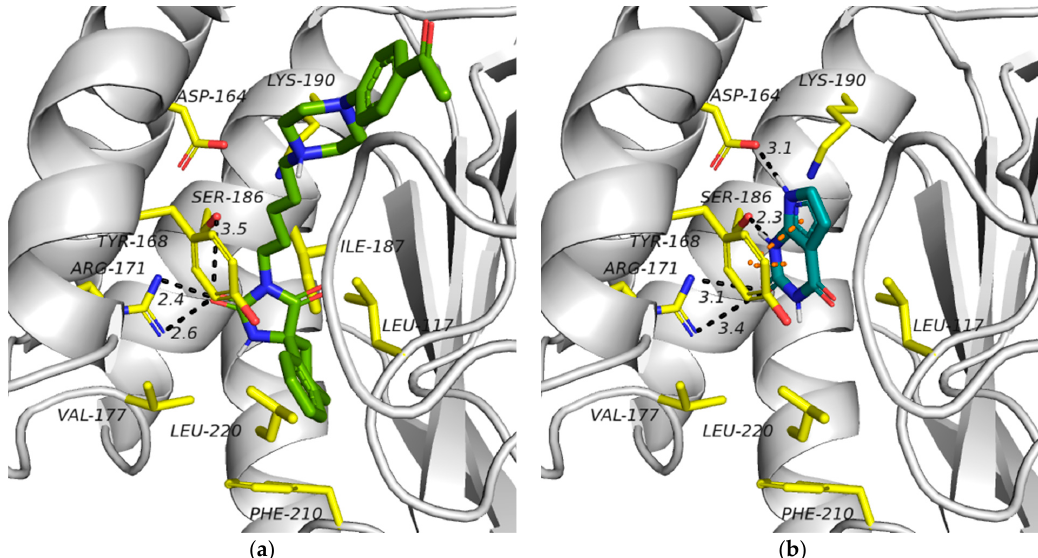
Figure 4. Binding mode of the R -isomer of compound 4 ( a ) and 7-DX ( b ) within the active site of TP. Amino acid residues colored in yellow. Hydrogen bonds and π – π stacking interactions are presented as black and orange dashes, respectively.